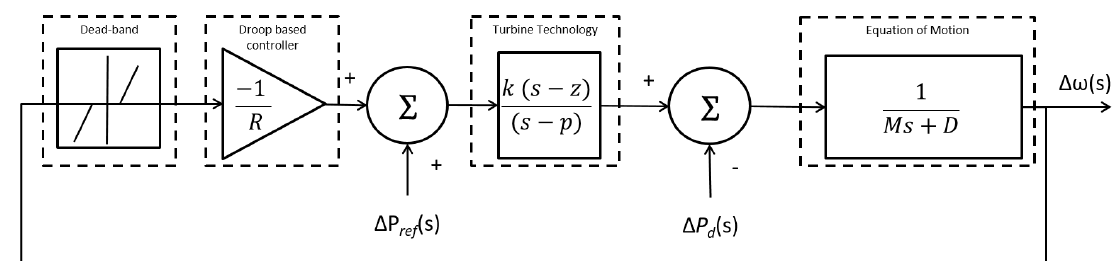
Figure 1. Frequency Containment Process (FCP) model for mathematical analytical